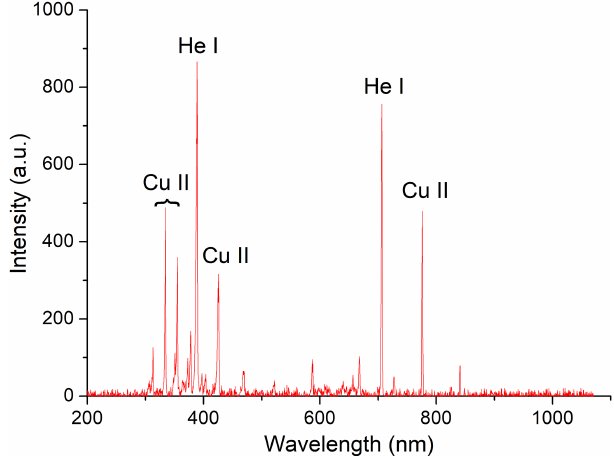
Figure 3. Typical OES spectrum in a helium plasma averaged over 50 scans. Experimental conditions: 15kHz driving frequency, 825V peak-to-peak voltage and a 180mL/Min He flow. Table 2. Measured central wavelengths compared to data from Kramida et al. (2013) and the associated particle species for the most prominent emission lines in Fig. 3. Wavelength from Measured central Kramida et Particle wavelength (nm) al. (2013) (nm)